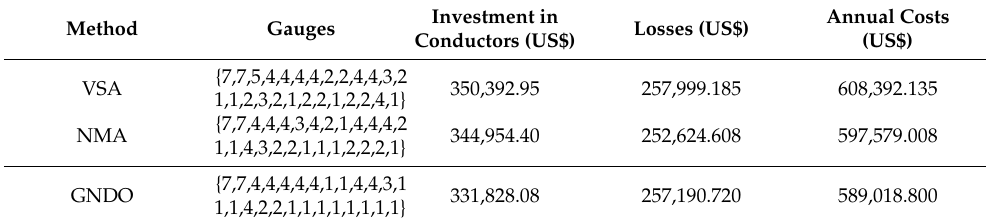
Table 12. Solutions obtained by different optimization